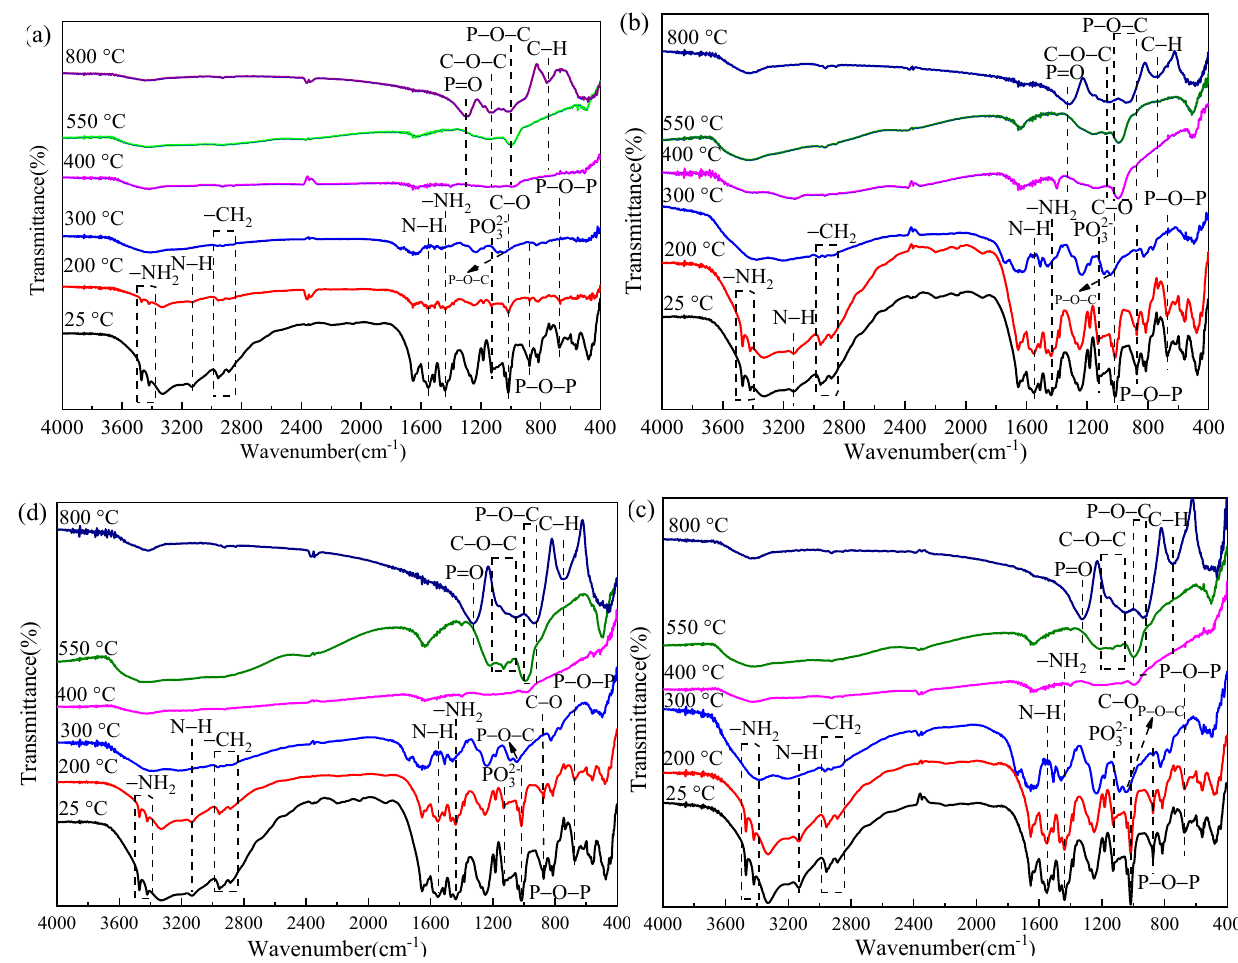
Figure 12. FTIR spectrum of intumescent fire-retardant Coatings under different treatment temperatures. ( a ) IFRC-0; ( b ) IFRC-CES; ( c ) IFRC-CHS; ( d ) IFRC-CMS. Table 6. FTIR assignments for the functional groups of the IFRCs under different treatment temperatures. Observations FTIR Band (cm − 1 ) Functional Groups